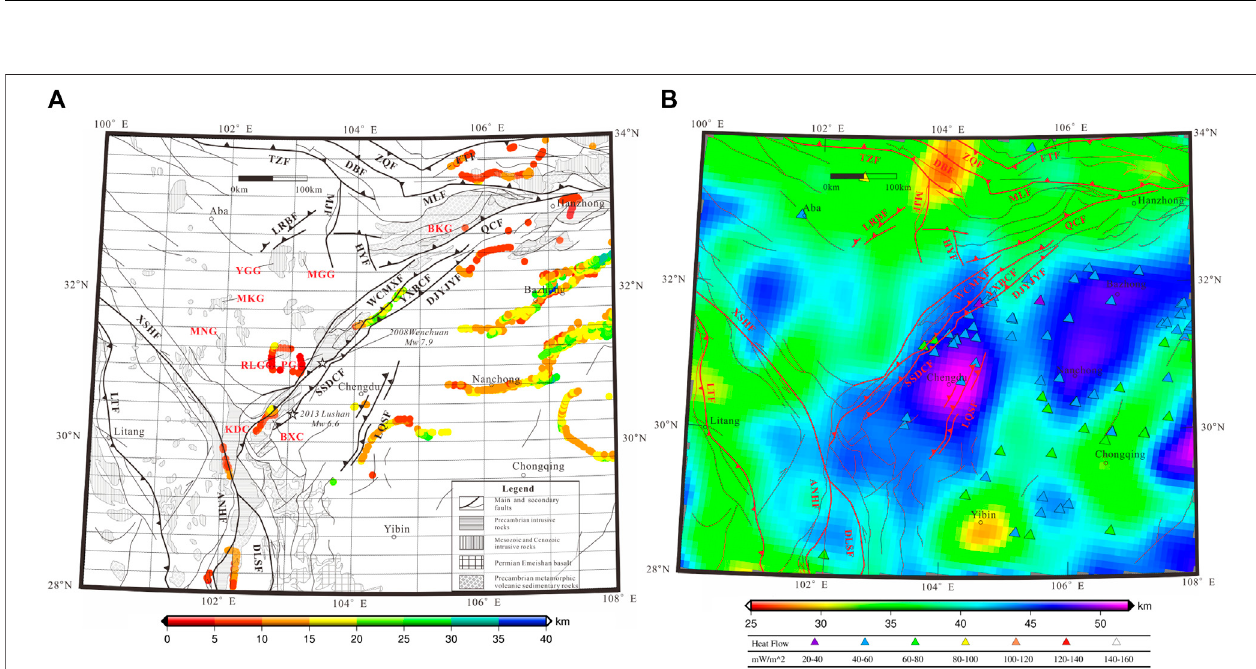
FIGURE 6 | Upward continuation of the magnetic anomaly at (A) 10 km; (B) 25 km calculated from RTP anomalies (Figure 4) .